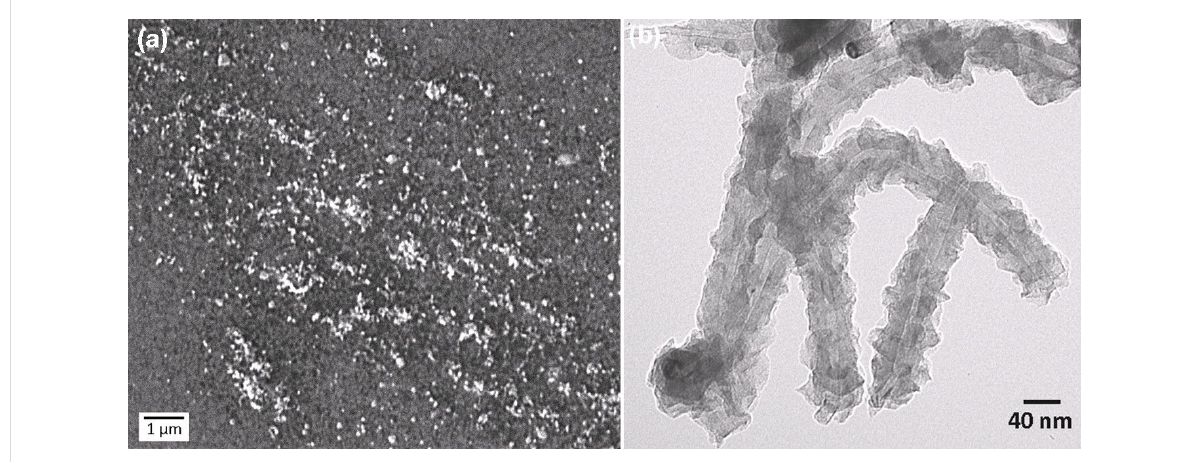
Figure 3: (a) SEM image showing the surface of Sample C, on which a low density mat of MWCNTs is grown after CVD at 500 °C for 30 min. (b) TEM image of CNTs from Sample B (grown in CVD for 30 min at 525 °C).